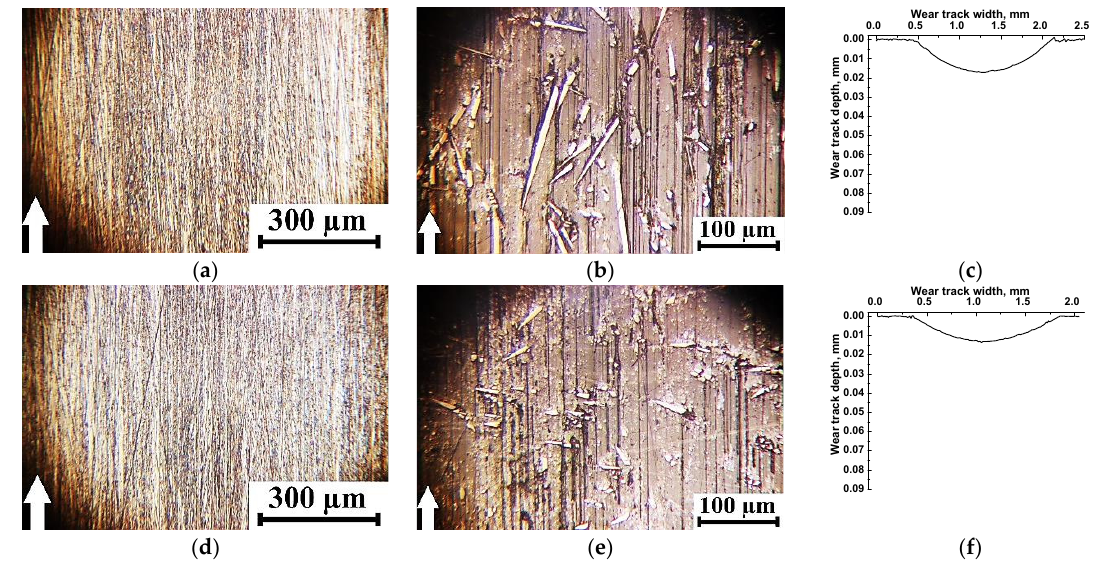
Figure 10. Optical photographs of the steel counterpart surfaces ( a , d ), wear tracks ( b , e ) and their profiles ( c , f ) after the tribological tests of the PEI/10CCF/1CNT ( a – c ) and PEI/10CCF/1HNT ( d – f ) nanocomposites. Linear tribological contact. P = 60 N, V = 0.3 m/s.